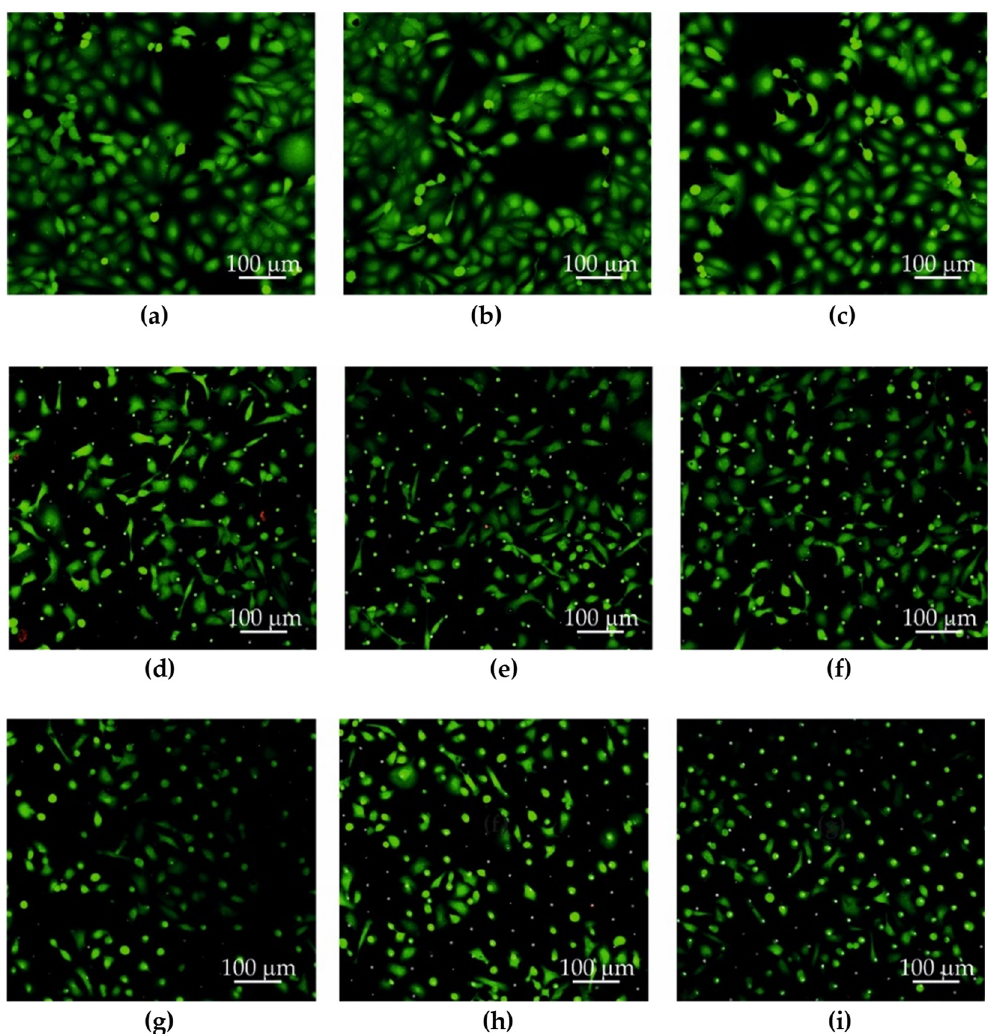
Figure 6. Culture of DU 145 cancer cells on a Petri dish ( a – c ), on an Au microsieve ( d – f ), and an Au + GO sieve ( g – i ). The LIVE/DEAD™ Viability/Cytotoxicity Kit was used for staining (cells stained green—living cells, cells stained red—dead cells).